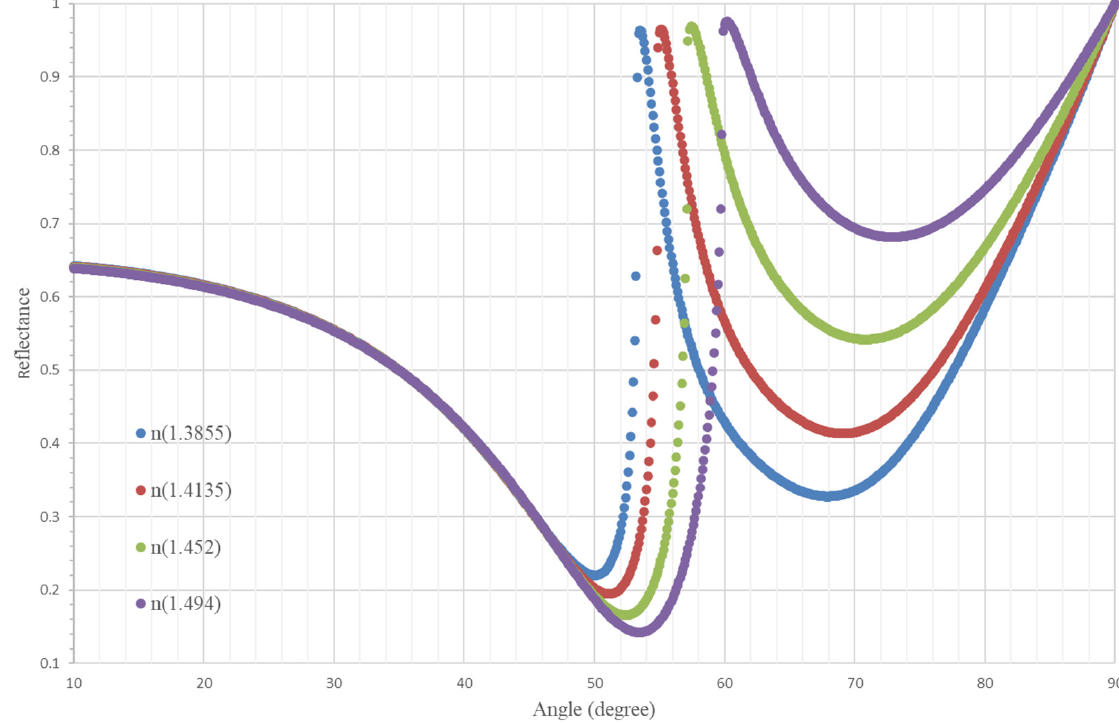
Figure 5. Reflectance curves as a function of the angle of incidence of the light in the prism for the range of refractive index values.